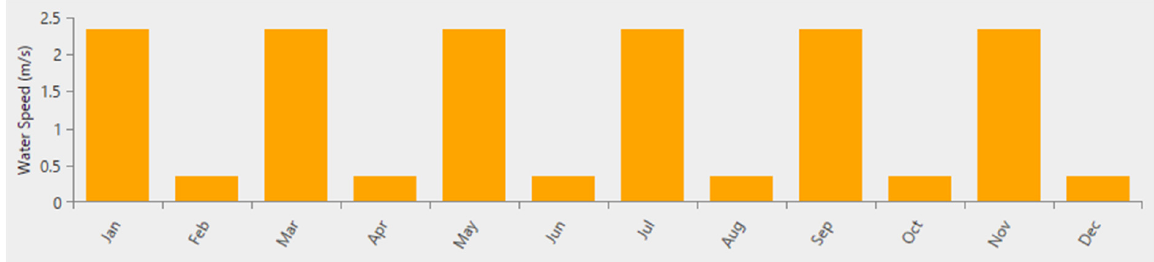
Figure 6. Hydrokinetic resource of Bristol.